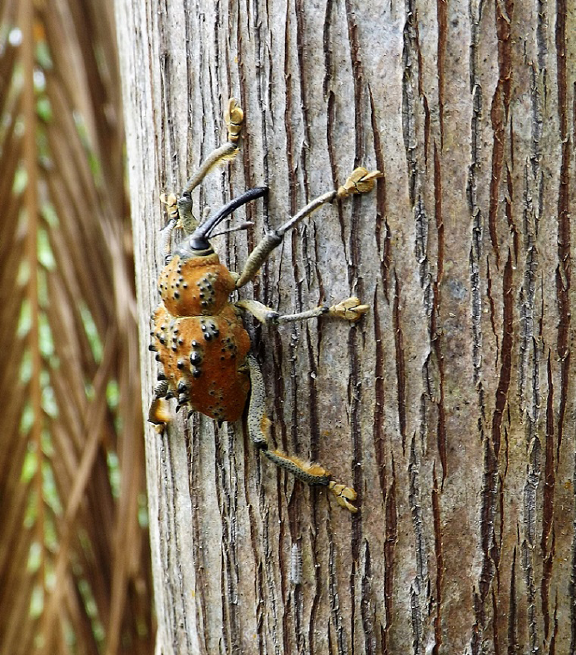
Figure 1. Adult of Ozopherus muricatus Pascoe, 1872 (Coleoptera: Curculionidae) on açaí palm, in the municipality of Buritis, Rondônia,